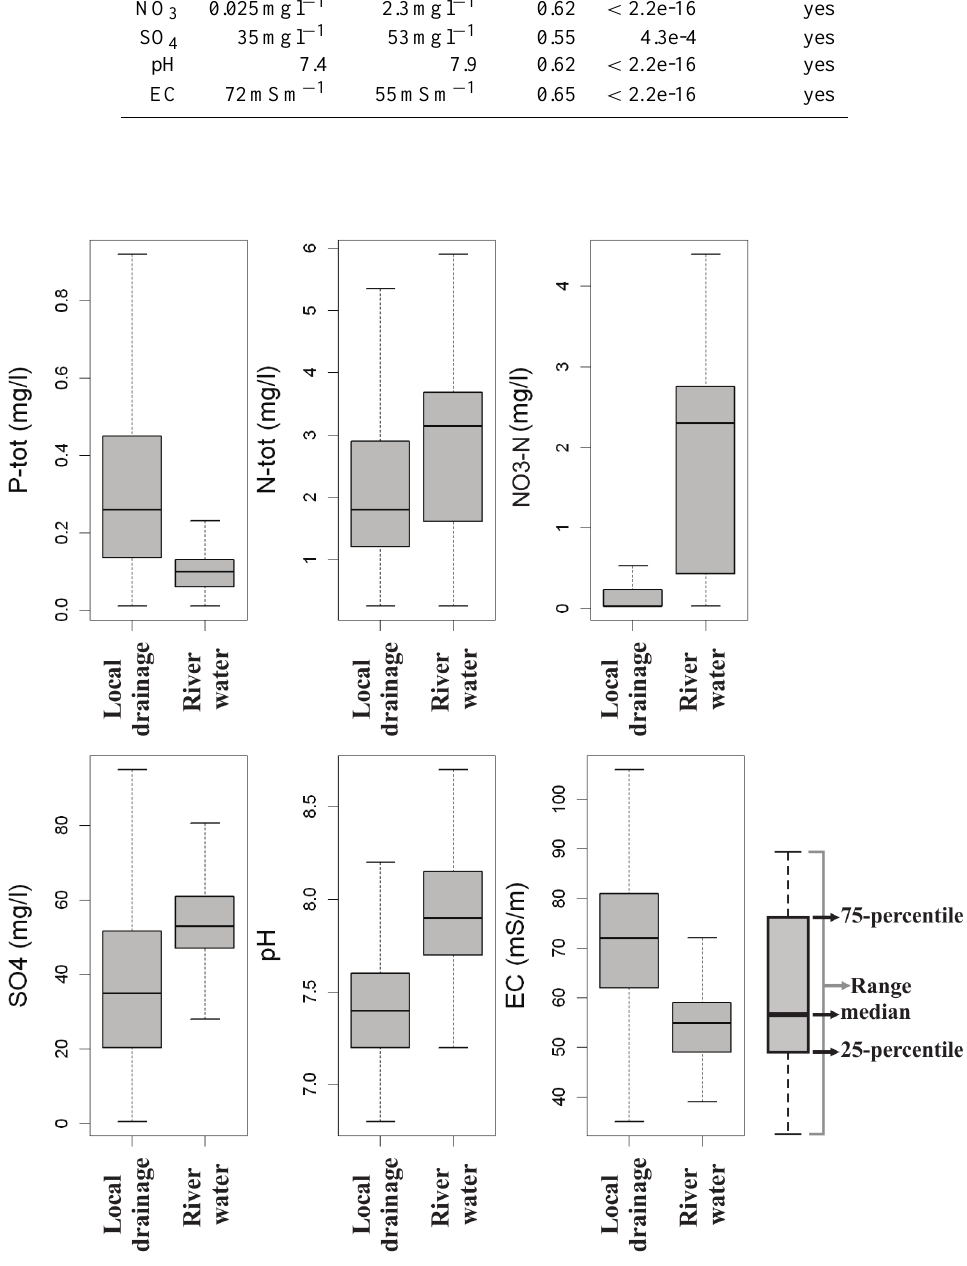
Fig. 3. Boxplots summarizing the 2003–2010 water quality monitoring data. The left-side boxplots represent the low Gd-anomaly moni- toring locations (local drainage dominated water) and the right-side boxplots represent the high Gd-anomaly locations (diverted river water dominated